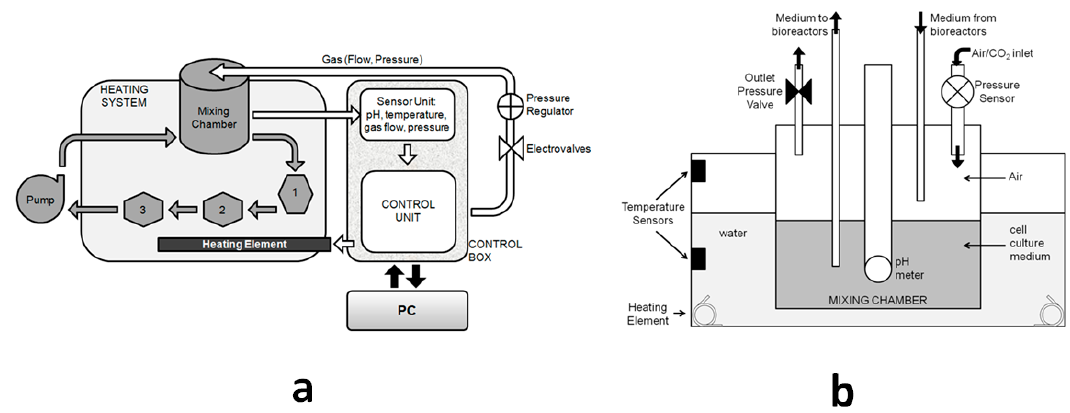
Figure 1. ( a ) Block diagram for the SUITE (Supervising Unit for In Vitro Testing) platform connected with several bioreactor units (represented by hexagons 1, 2, and 3); and ( b ) the detailed scheme of the mixing chamber in the heating system (image not to scale).